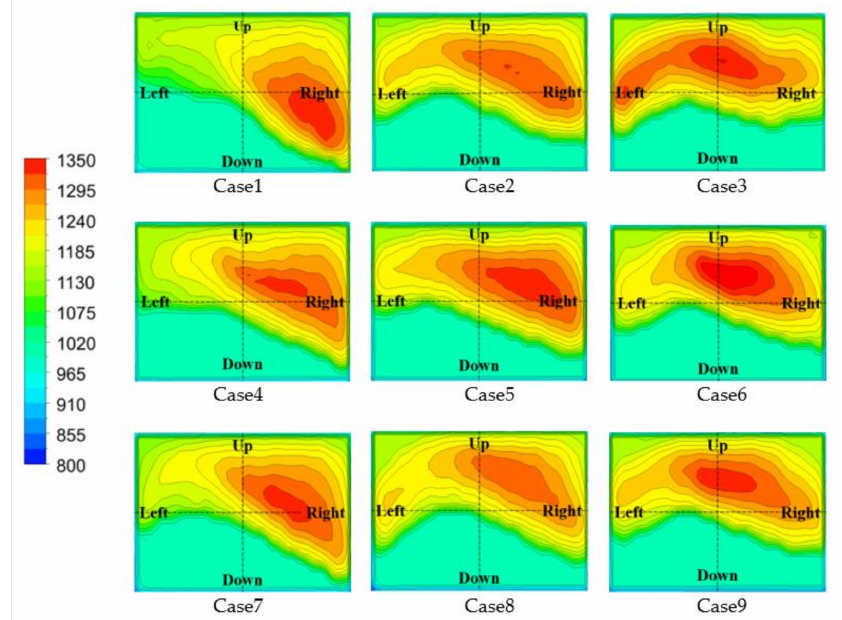
Figure 8. P4 section temperature distribution (temperature: